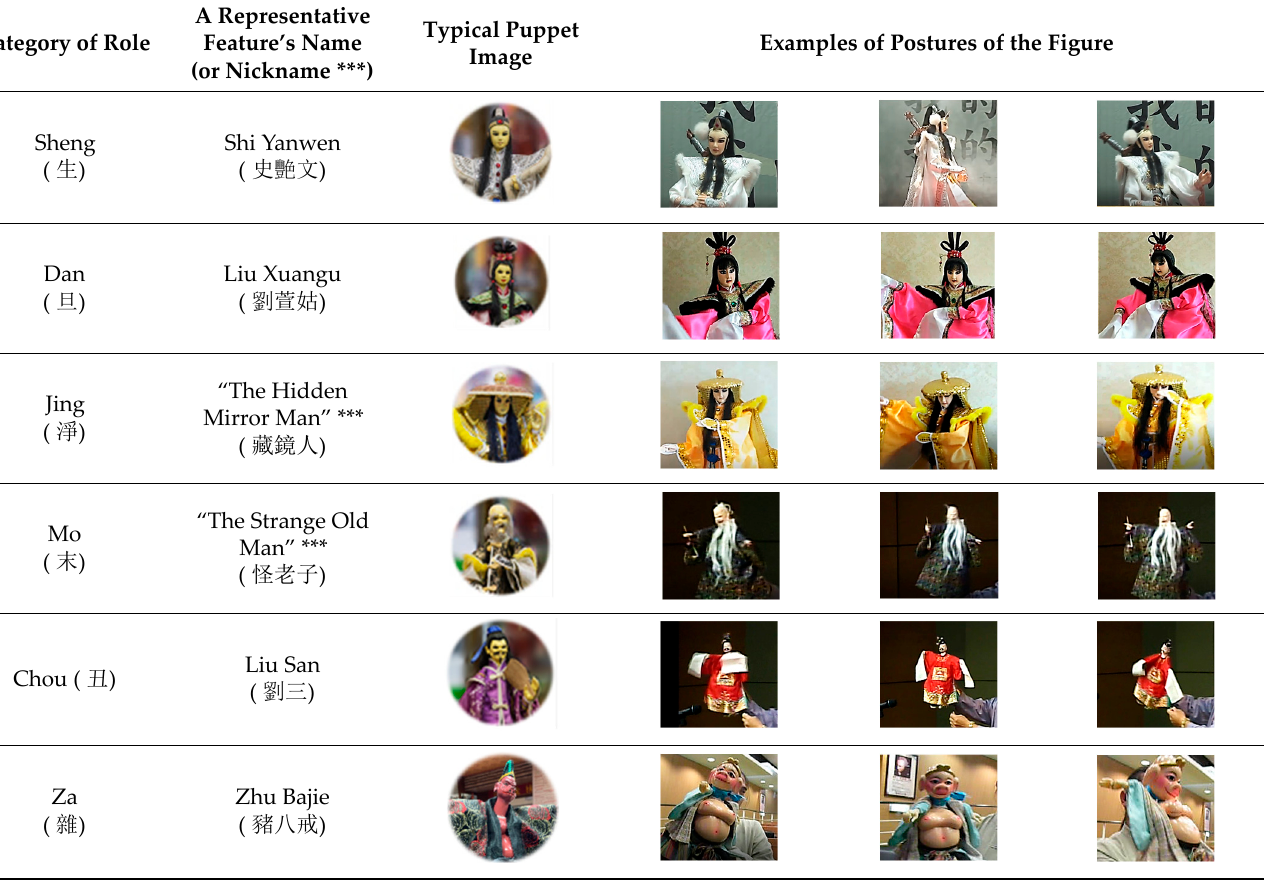
Table 2. Some examples of postures of the six roles of glove puppet characters in the traditional puppet show “The Great Confucian Hero of Yunzhou”.